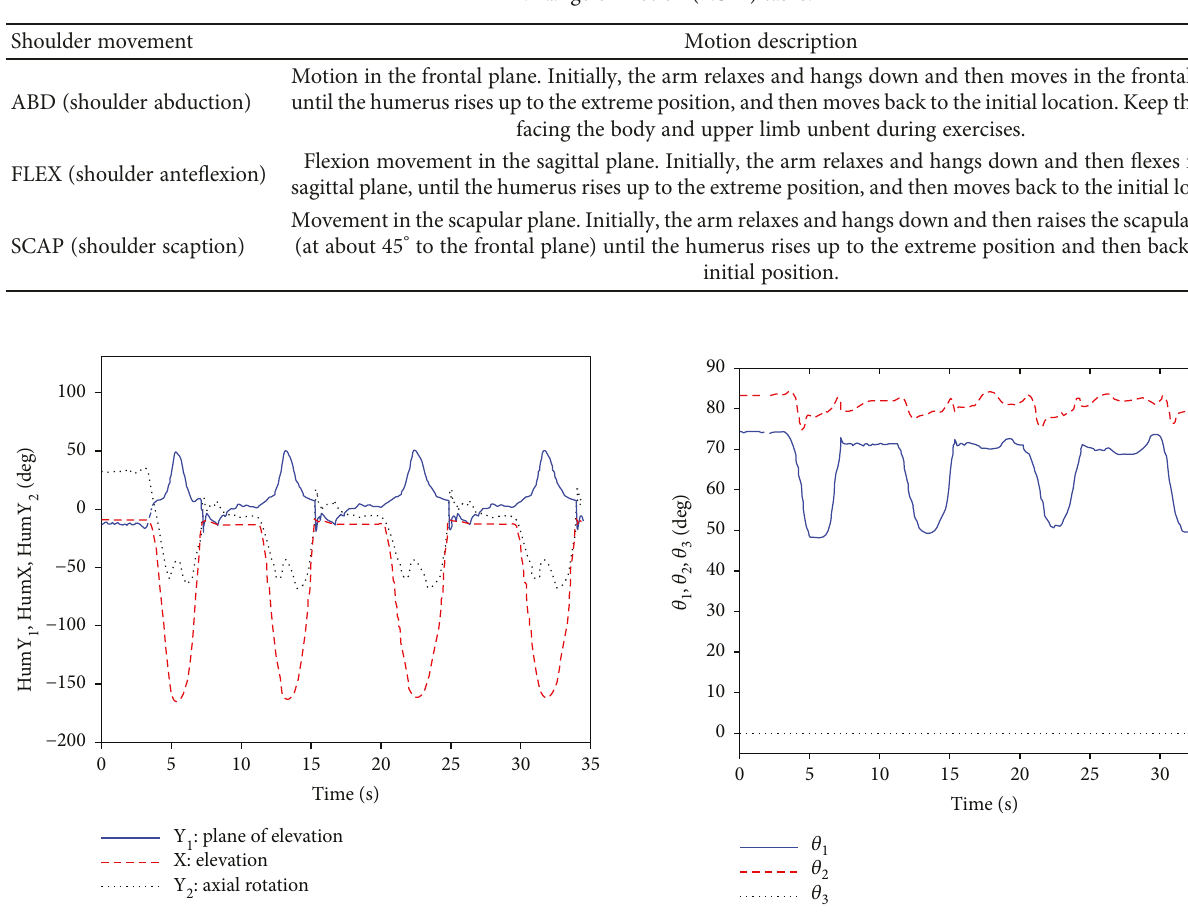
Table 4: Range of motion (ROM) tasks.